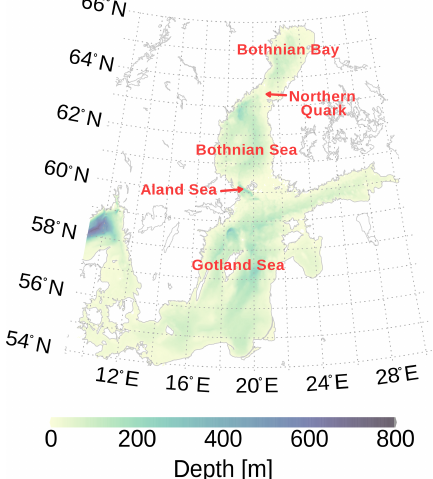
Figure 1. Bathymetry of the Baltic Sea showing names of different geographic regions we will use in the text. The map was created using the software package GrADS 2.1.1.b0 (http://cola.gmu.edu/ grads/, last access: 19 June 2020), using published bathymetry data (Seifert et al.,